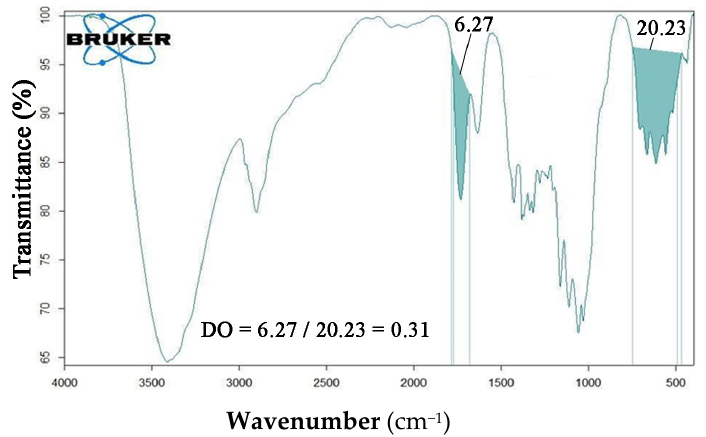
Figure 2. FT-IR analysis of ONC in the acid form.